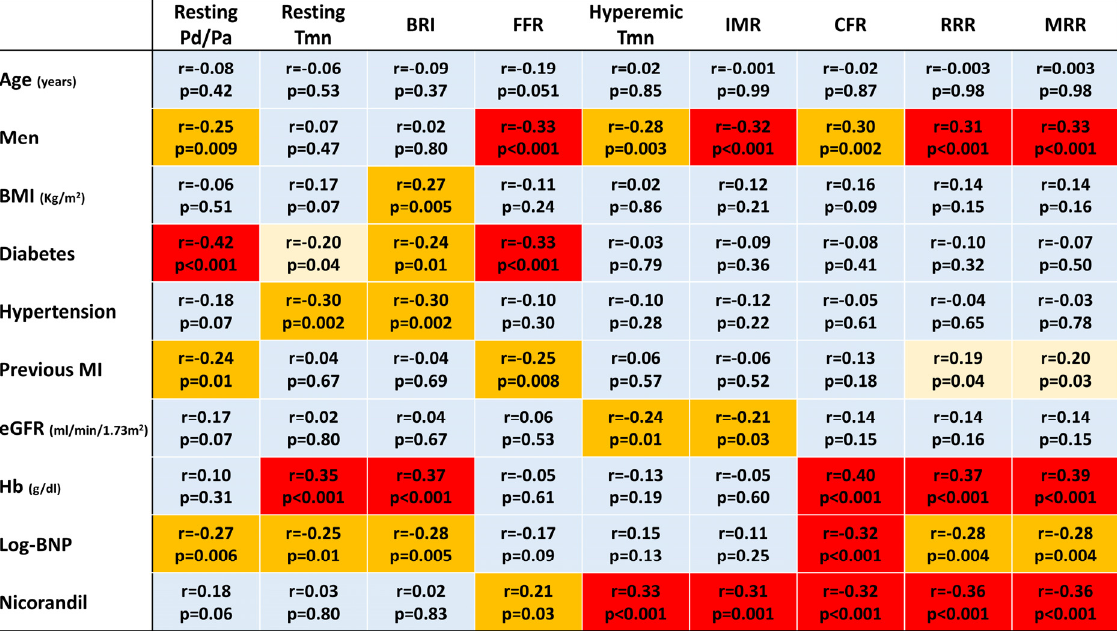
Figure 4. A heat map for multivariable linear regression analyses. A cell in light blue indicates no significant association ( p ≥ 0.05). When significant associations are found ( p < 0.05), cells are